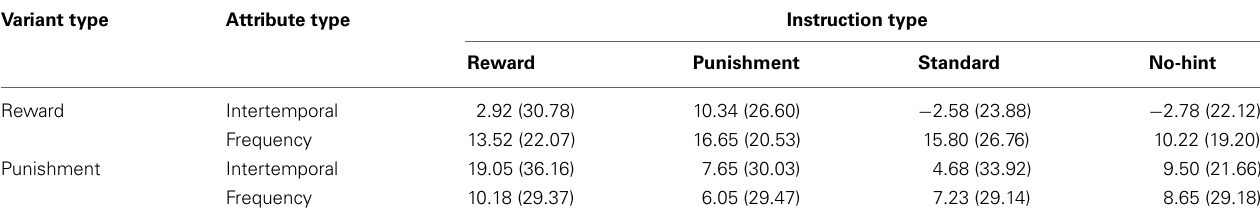
Table 1 | Descriptive statistics for instruction type, variant type, and attribute type ( n = 320).